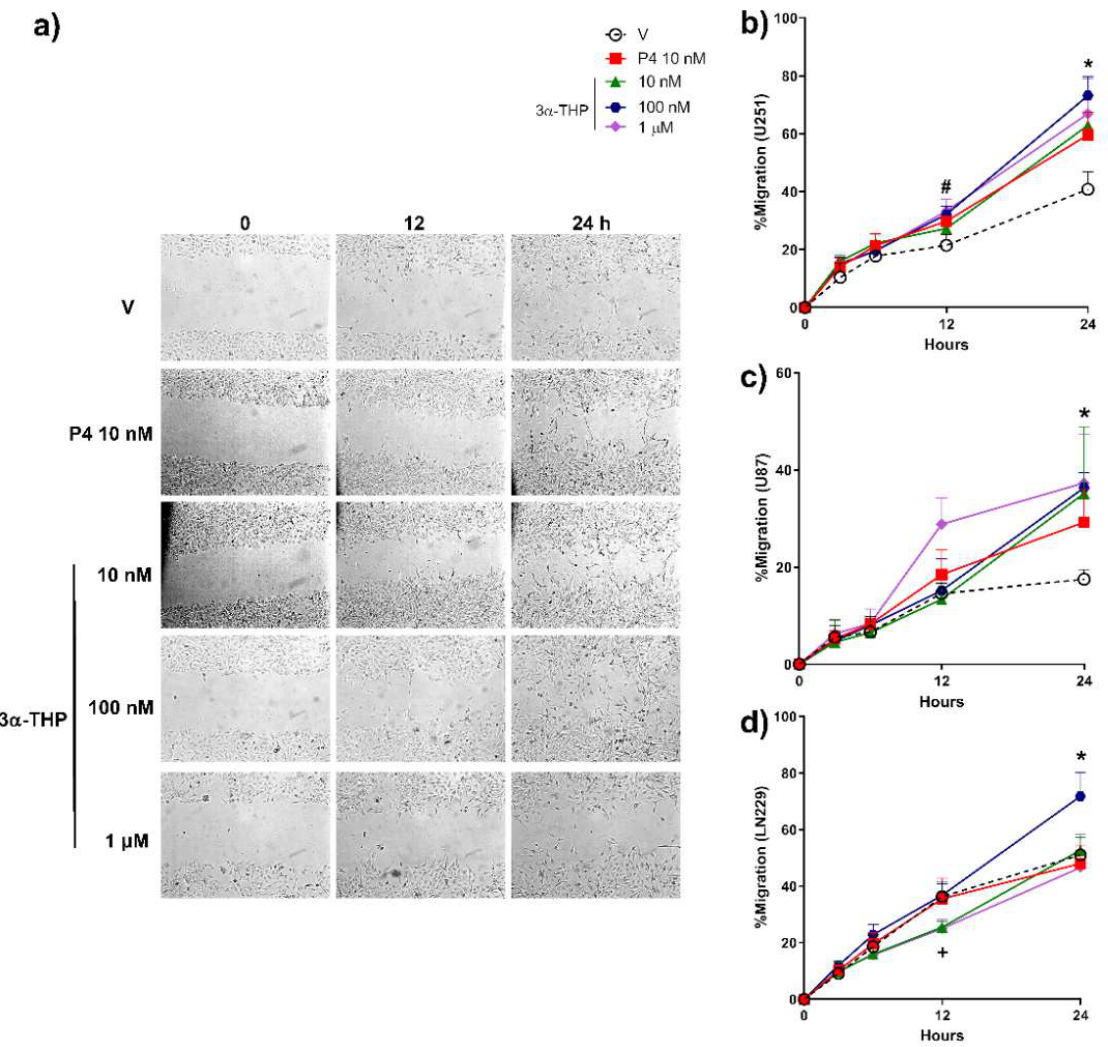
Figure 1. Effect of 3α-THP on human GB cell migration. ( a ) Representative images of the scratch area from U251 cells treated with vehicle (V, ethanol 0.1% in the medium), progesterone (P4; 10 nM), or allopregnanolone (3α-THP; 10, 100 nM and 1 µM). Percentage migration graphs of ( b ) U251, ( c ) U87, and ( d ) LN229 human GB cell lines. Each point represents the mean ± SEM. U251 (Graph b): # p < 0.05 for P4 and 3α-THP 100 nM vs. V; * p < 0.05 for P4 and all concentrations of 3α-THP vs. V. U87 (Graph c): * p < 0.05 for 3α-THP 10 nM, 100 nM and 1 µM vs. V. LN229 (Graph d): + p < 0.05 3α-THP 10 nM and 1 µM vs. V; * p < 0.05 for 3α-THP 100 nM vs. all other treatments. n = 3 for U251 and U87 cells; n = 4 for LN229 cell line.